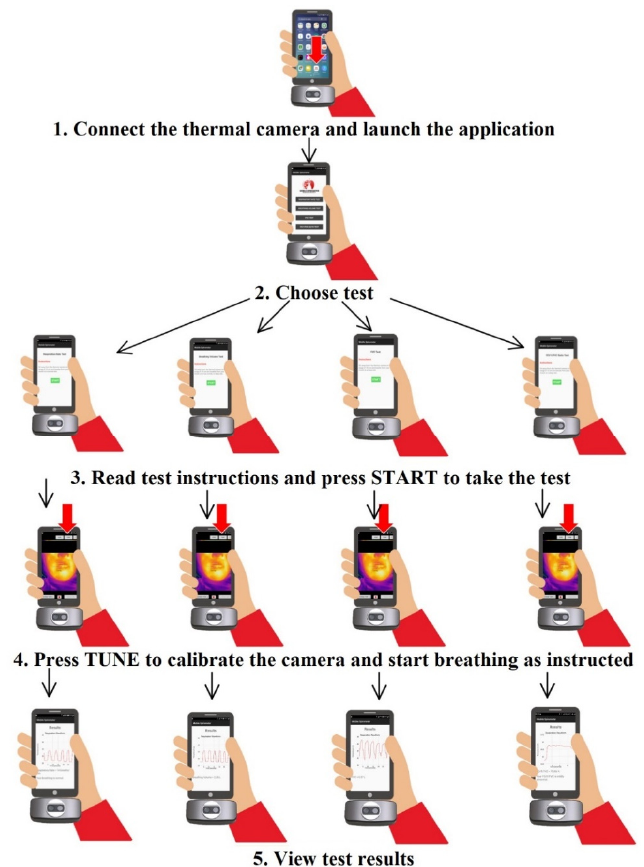
Sensors 2021 , 21 , x FOR PEER REVIEW Figure 6. Mobile application functionality of the proposed system. Figure 6. Mobile application functionality of the proposed system.